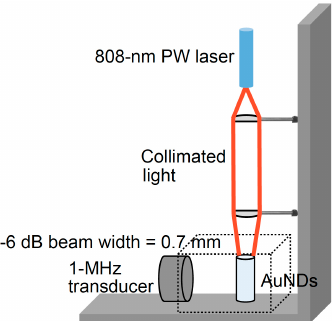
Figure 1. Laser beam setup.